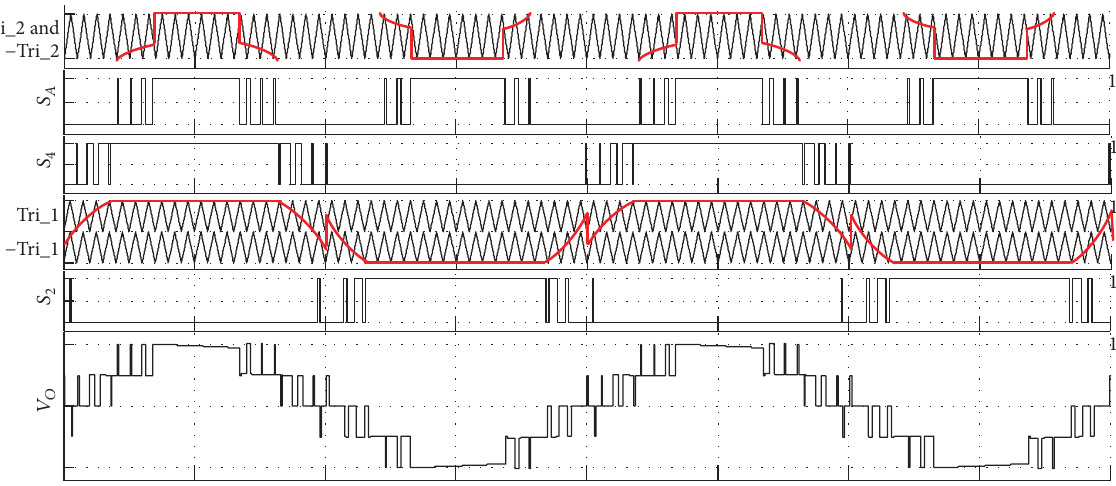
Figure 6: Reference and carrier signals required for modulation of a five-level switched-capacitor inverter.